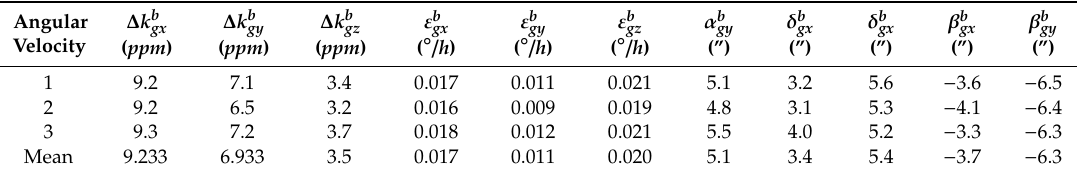
Table 4. Calibration